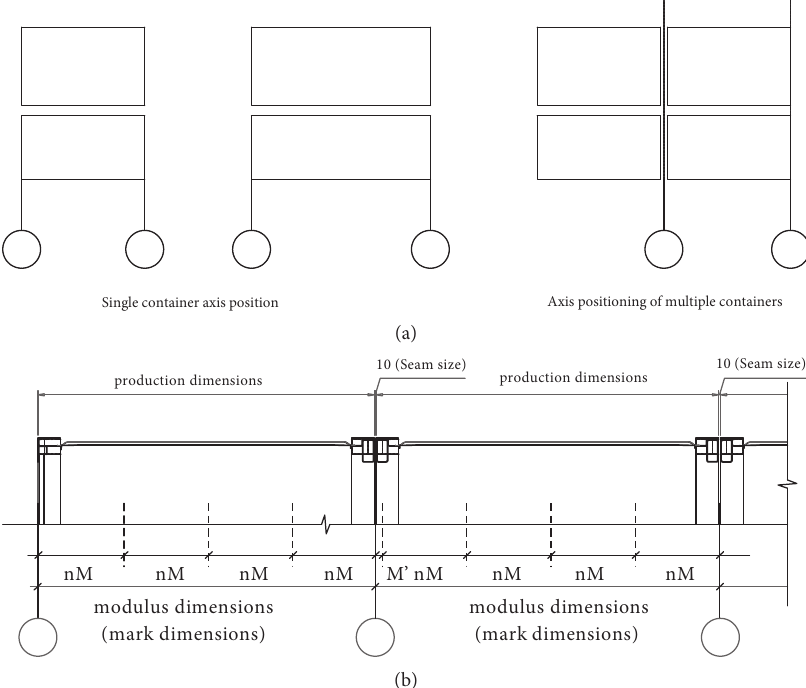
Figure 3: Principle of positioning. (a) Schematic diagram of axis positioning principles. (b) Schematic diagram of the seam, nominal dimensions, and structural